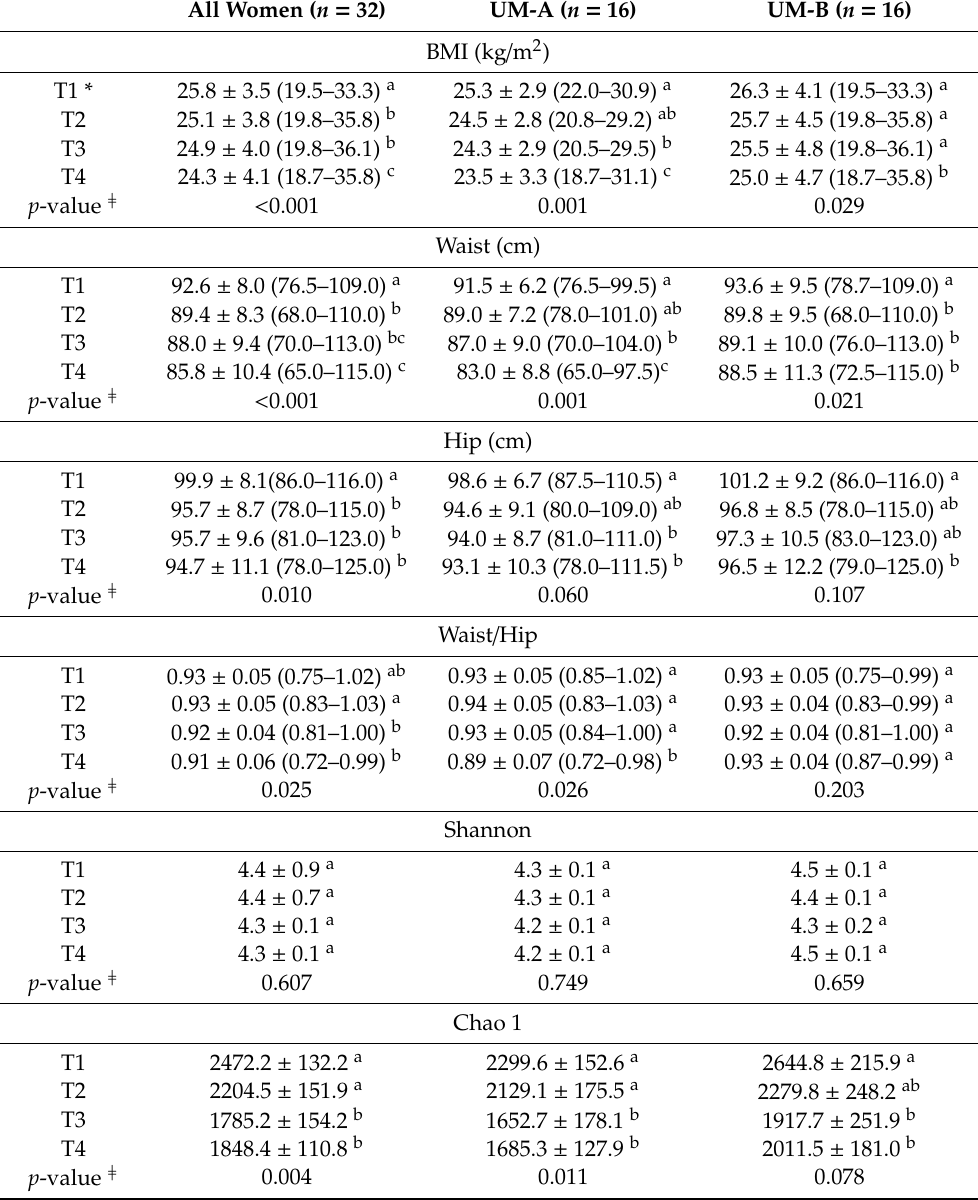
Table 2. Anthropometric values and α -diversity (Shannon and Chao 1 indexes) in women over one year after giving